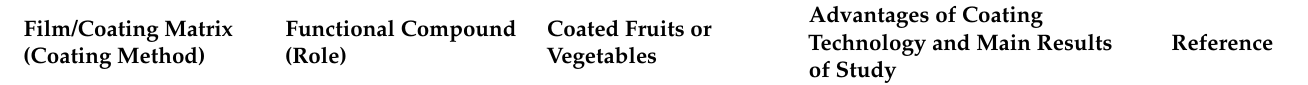
Table 1. Effect of edible coatings/films with different functional ingredients on fruits and vegetables